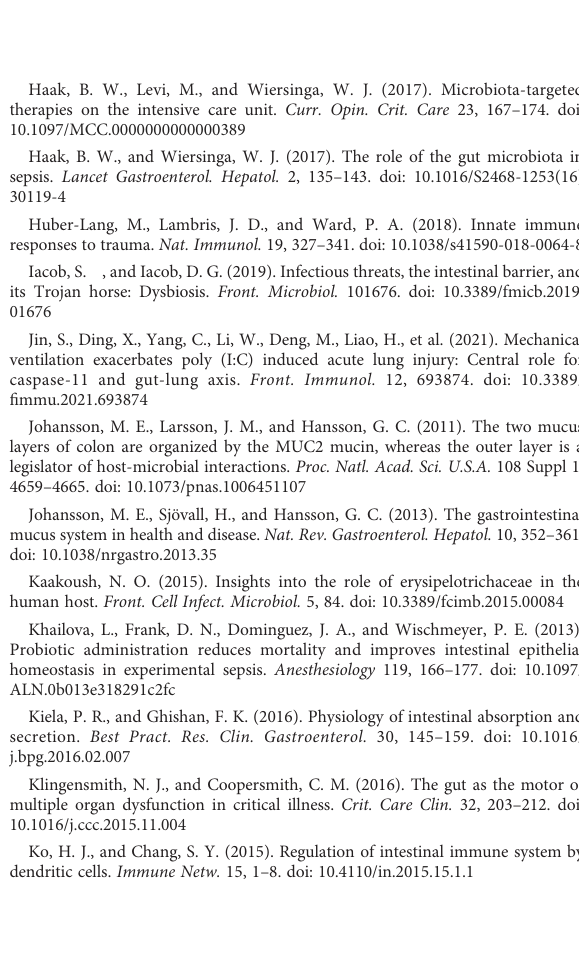
SUPPLEMENTARY TABLE S5 Changes in the abundance of the microbiota in different intestinal segments in the CLP6h